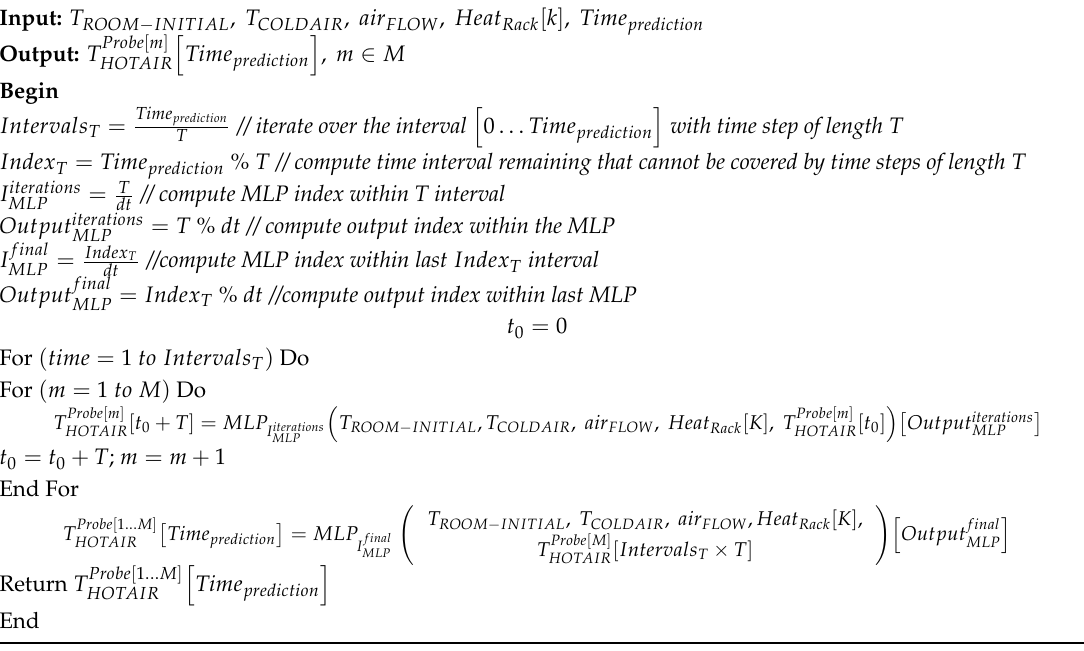
Algorithm 1. Heat Prediction Algorithm for Long Time